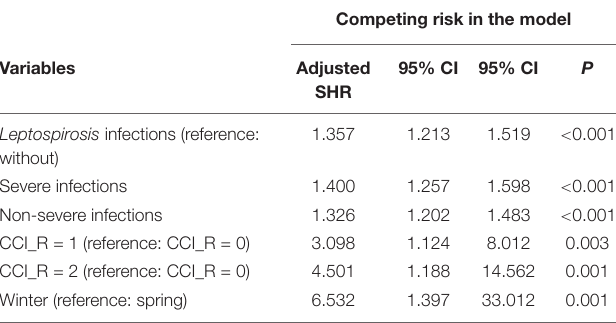
TABLE 2 | Antibiotics usage and the risk of dementia by using Fine and Gray’s competing risk